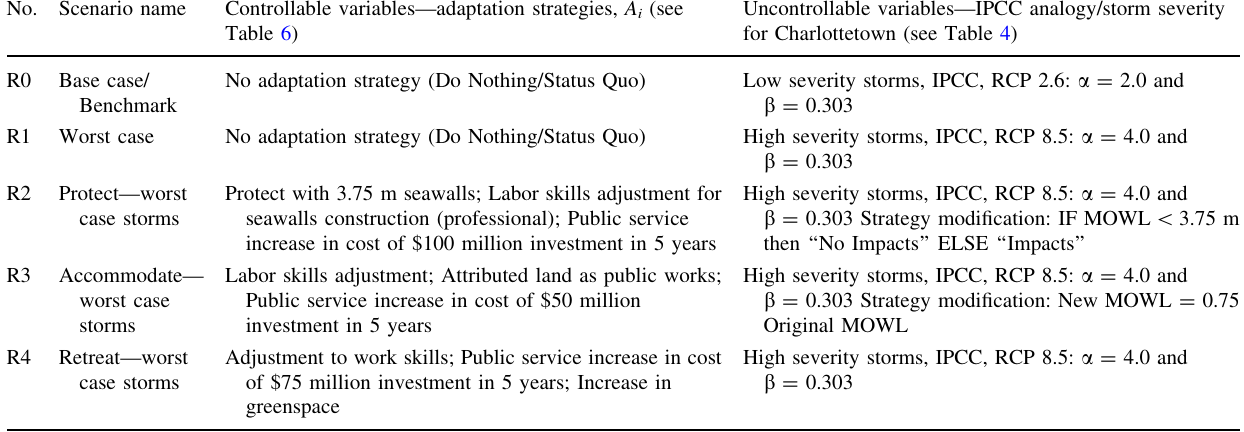
Table 7 System dynamics model scenario definitions for the city of Charlottetown, Prince Edward Island No. Scenario